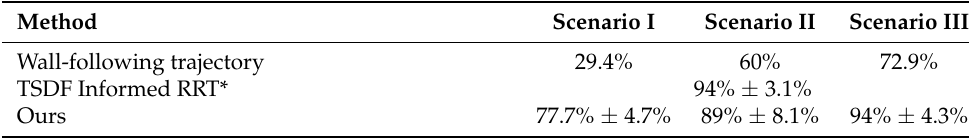
Table 5. Tunnel exploration percentage for all methods and